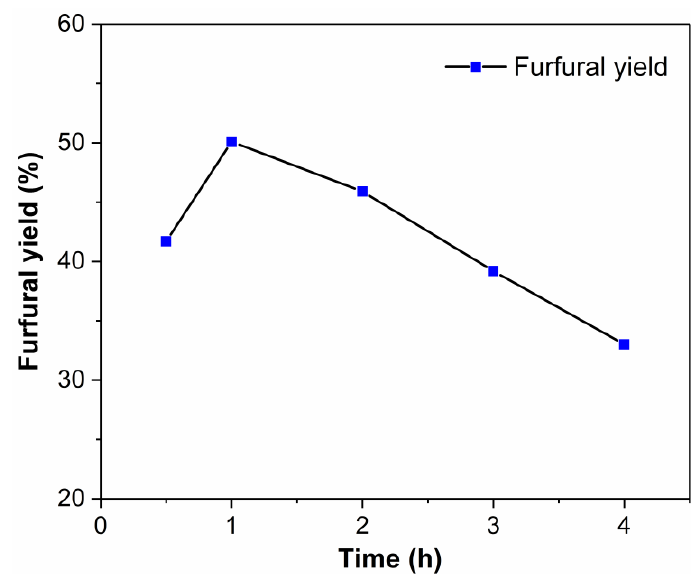
Figure 9. Time profile for the conversion of xylan to furfural in the EMIMBr/SnCl 4 system. Reaction